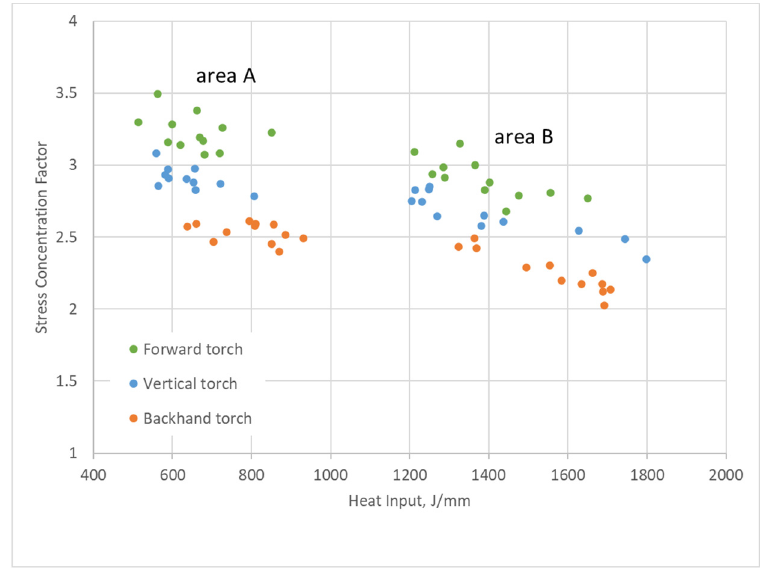
Figure 3. Influence of welding technique and heat input on the stress concentration factor of the welded joint.